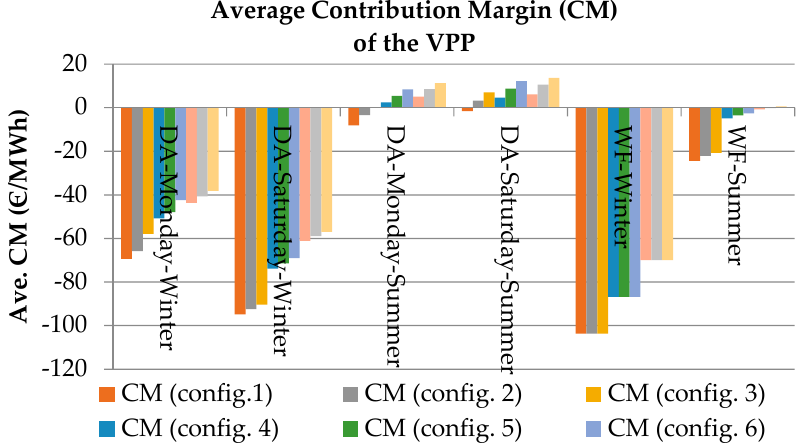
Figure 13. Average contribution margin of the VPP relative to the average market prices for different market products.